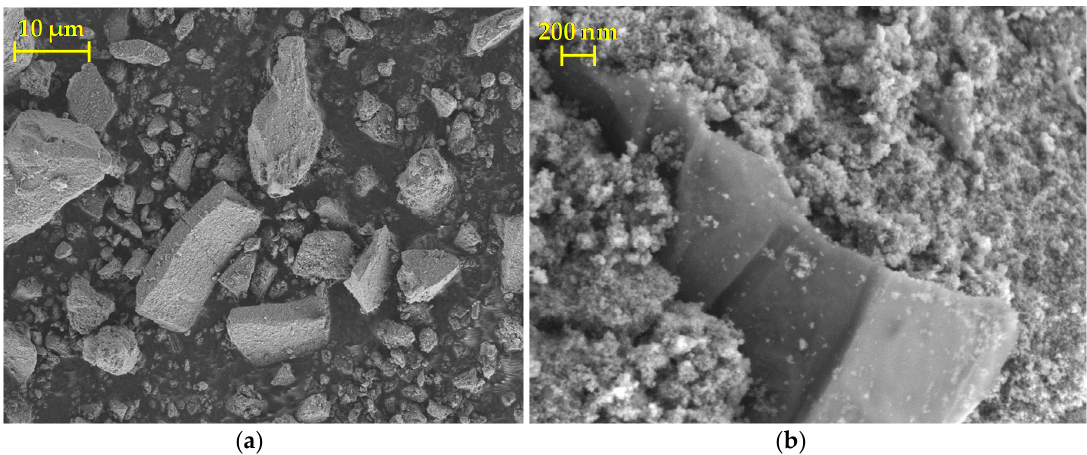
Figure 3. Scanning electron microscopy (SEM) micrographs depicting: ( a ) S-TiO 2 /rGO(5.0%) agglomerates; ( b ) rGO sandwiched in S-TiO 2 matrix.